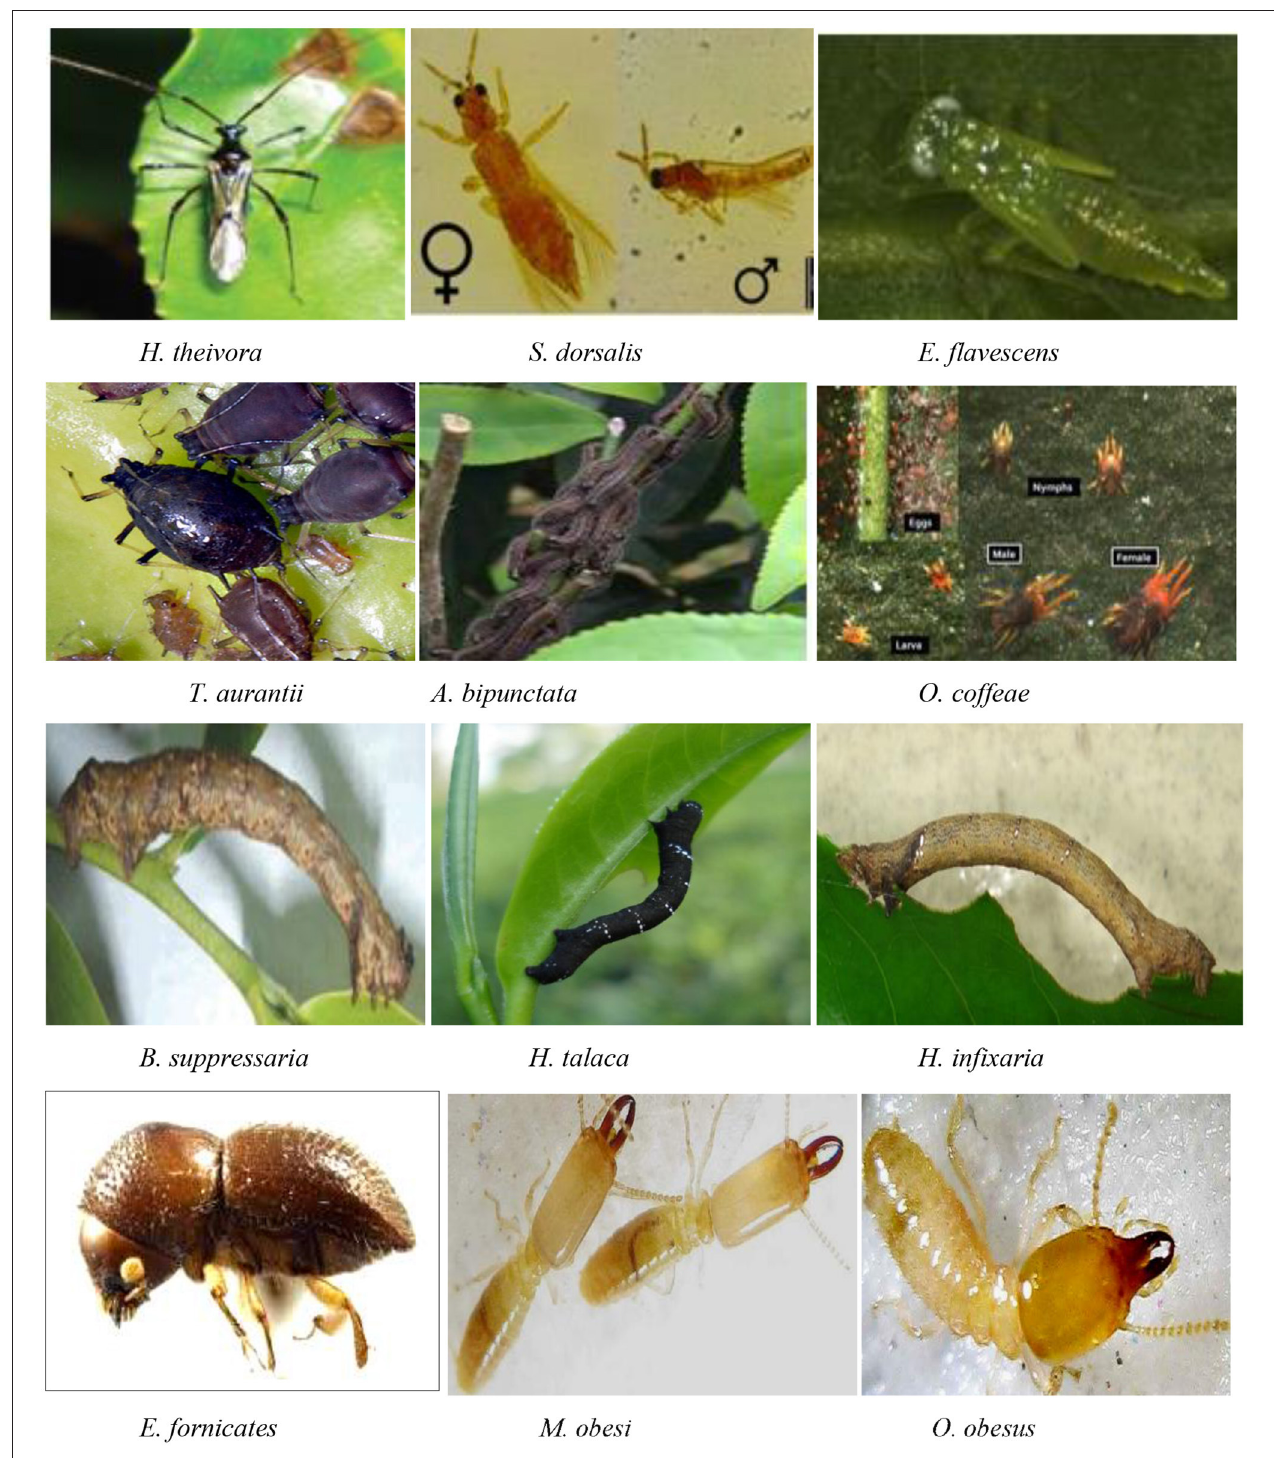
FIGURE 1 | Major pests of tea